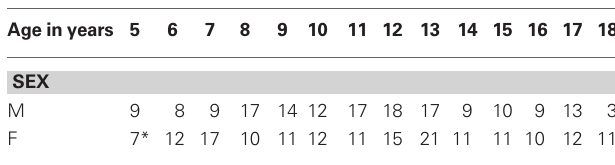
Table 1 | Age and gender breakdown of the study population (165 boys and 171